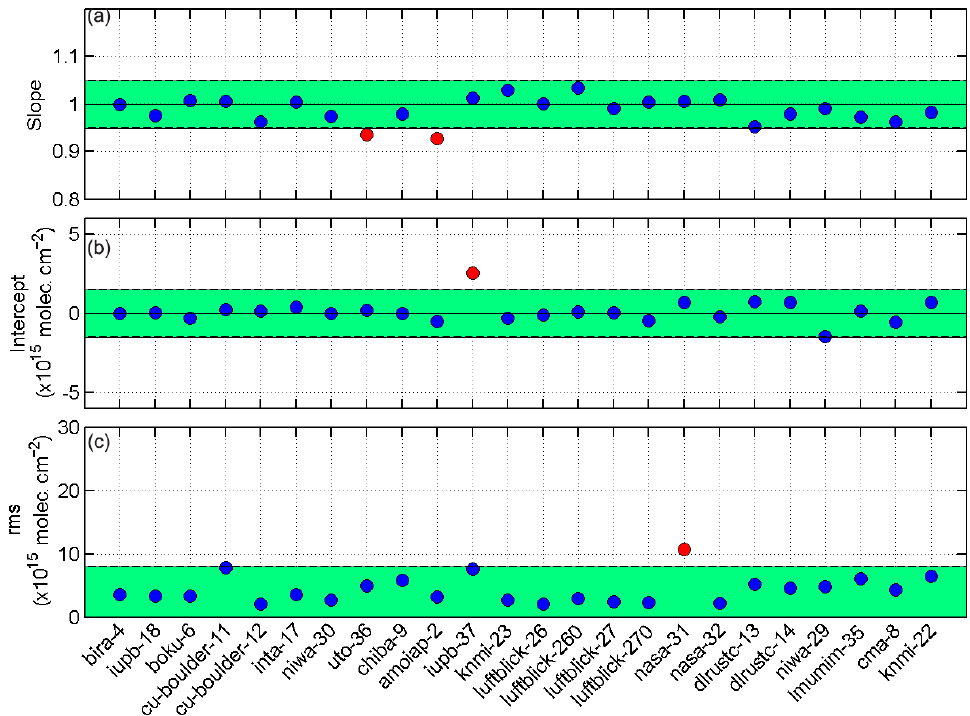
Figure 19. Summary of the NO 2 visible regression statistic shown in Fig. 10. The slope, intercept and rms values are displayed in (a) , (b) and (c) , respectively, for all measurement days, all viewing directions and all elevation angles. The green shading indicates the limits as defined in Table 4 and Fig. 18 for NO2vis; the values falling within these limits are plotted in blue, the ones outside the limits in